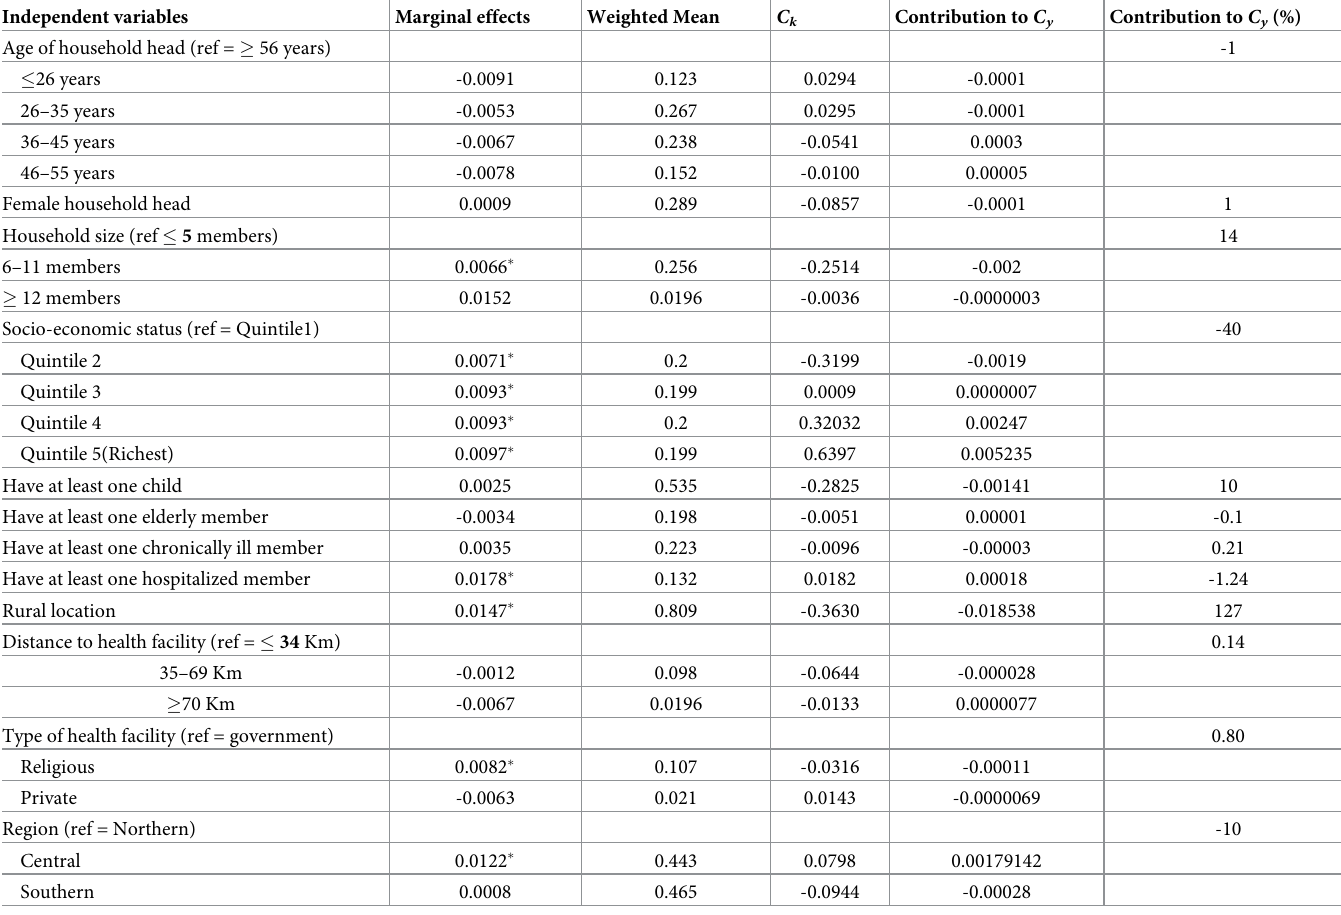
Table 3. Decomposition analysis of concentration index for catastrophic health